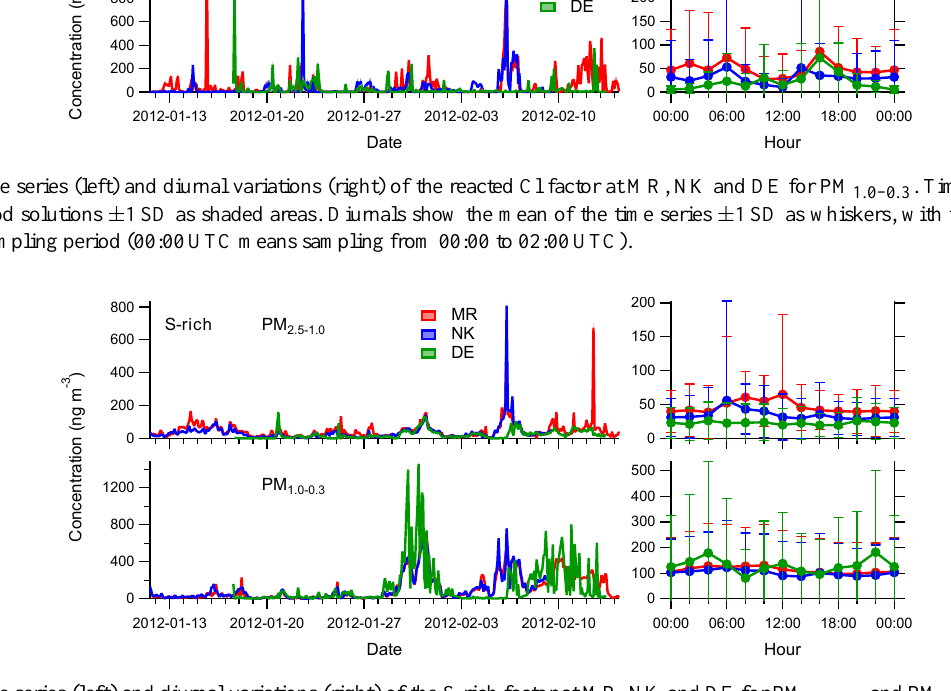
Figure 11. Time series (left) and diurnal variations (right) of the S-rich factor at MR, NK and DE for PM 2 . 5–1 . 0 and PM 1 . 0–0 . 3 . Time series show the mean of all good solutions ± 1SD as shaded areas. Diurnals show the mean of the time series ± 1SD as whiskers, with the hour being the start of a 2h sampling period (00:00UTC means sampling from 00:00 to